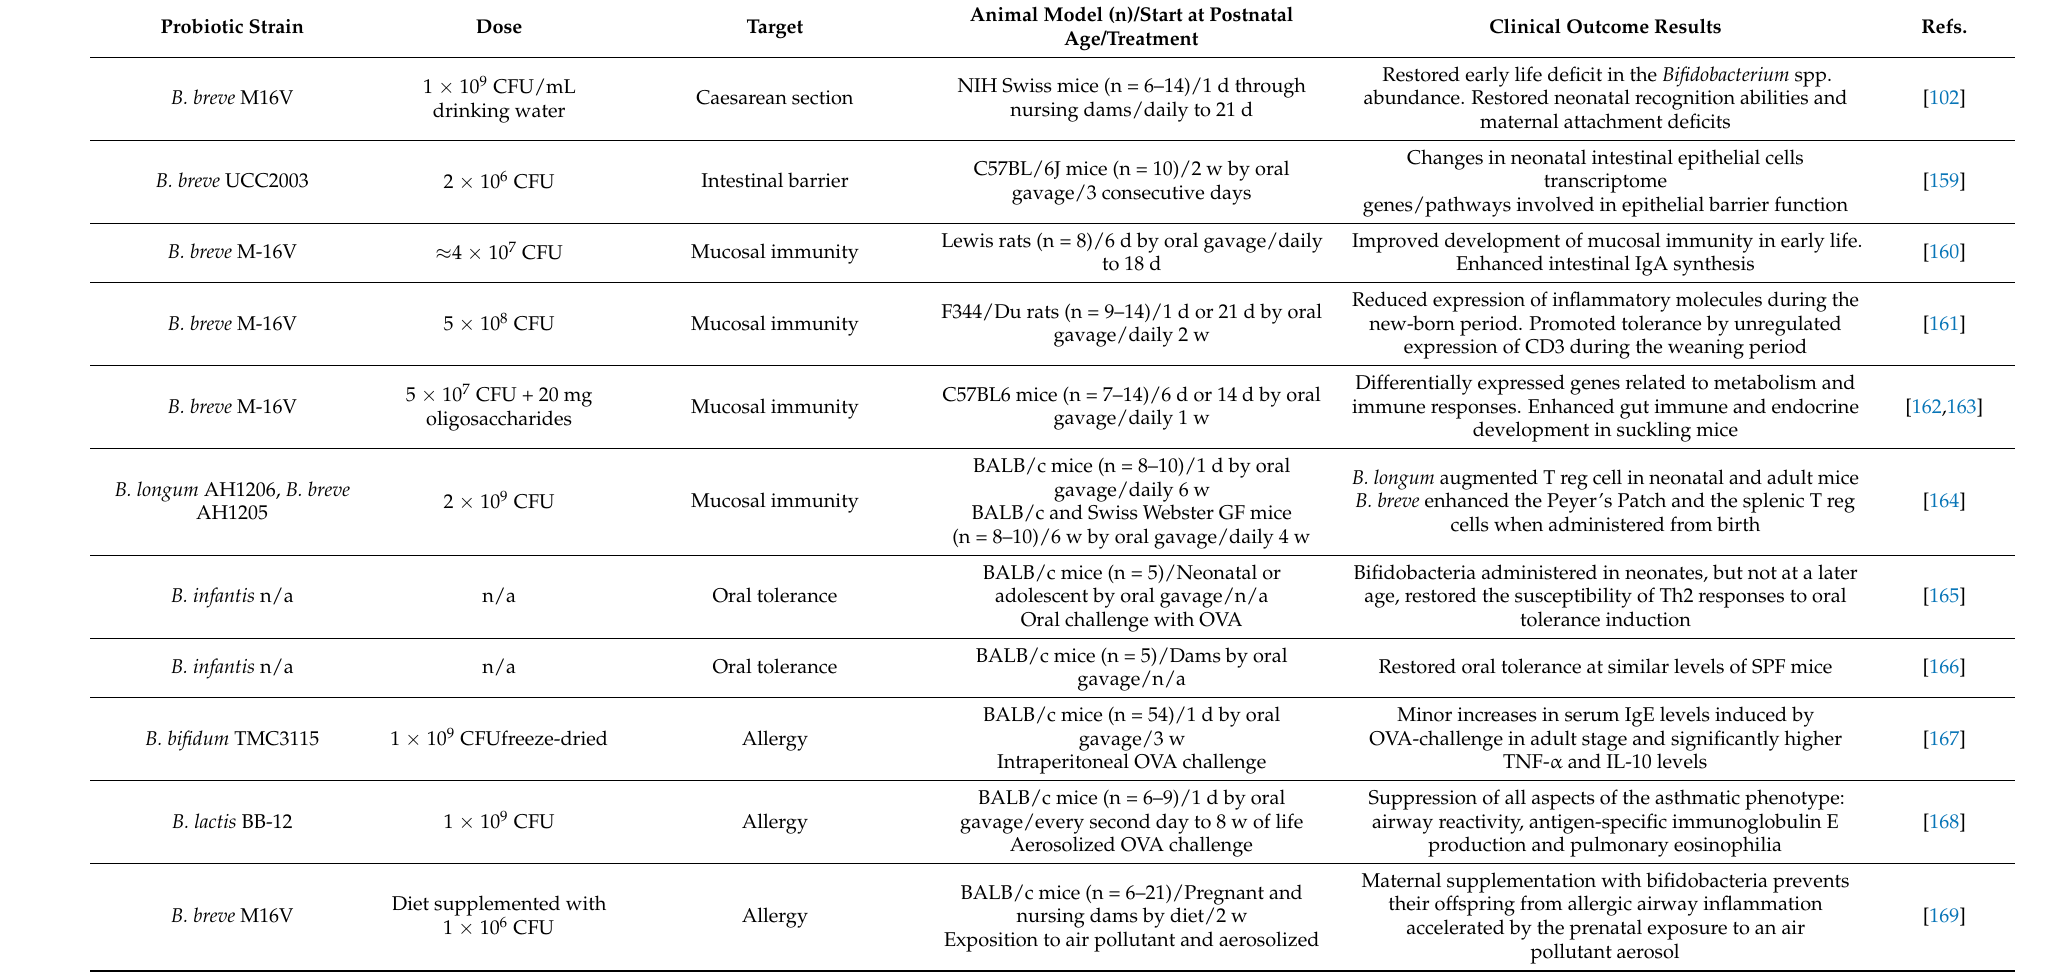
Table 1. Examples of animal studies evidencing the impact of different Bifidobacterium strains in early